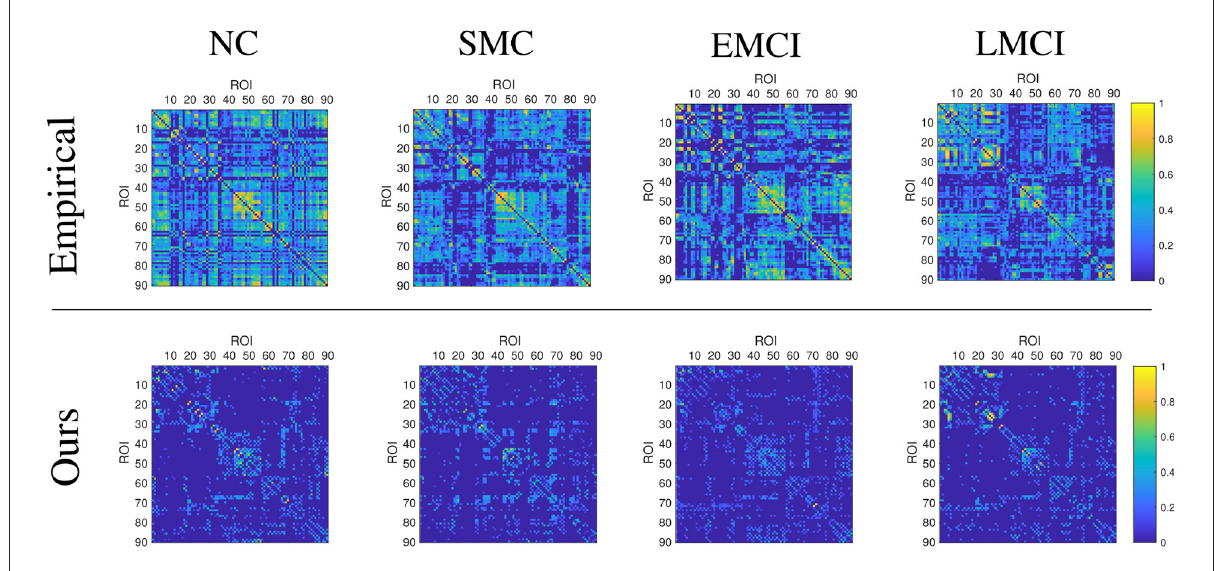
FIGURE5 Display of brain functional network examples at different disease stages. The BFNs in the upper row are generated by the GRETNA toolbox, and the BFNs in the lower row are generated by the proposed model.